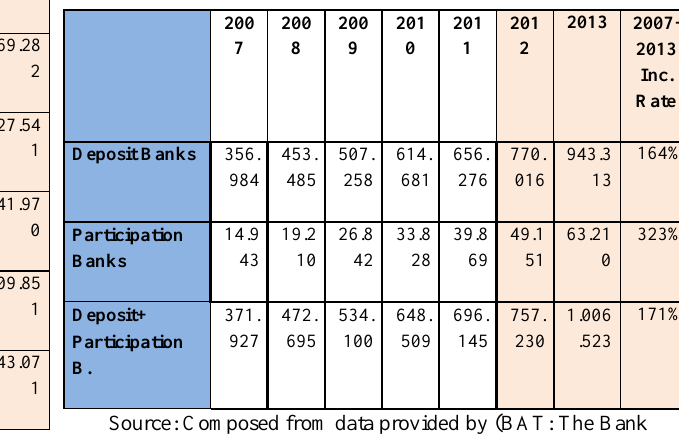
Table-9: Fund Distribution of Participation and Deposit